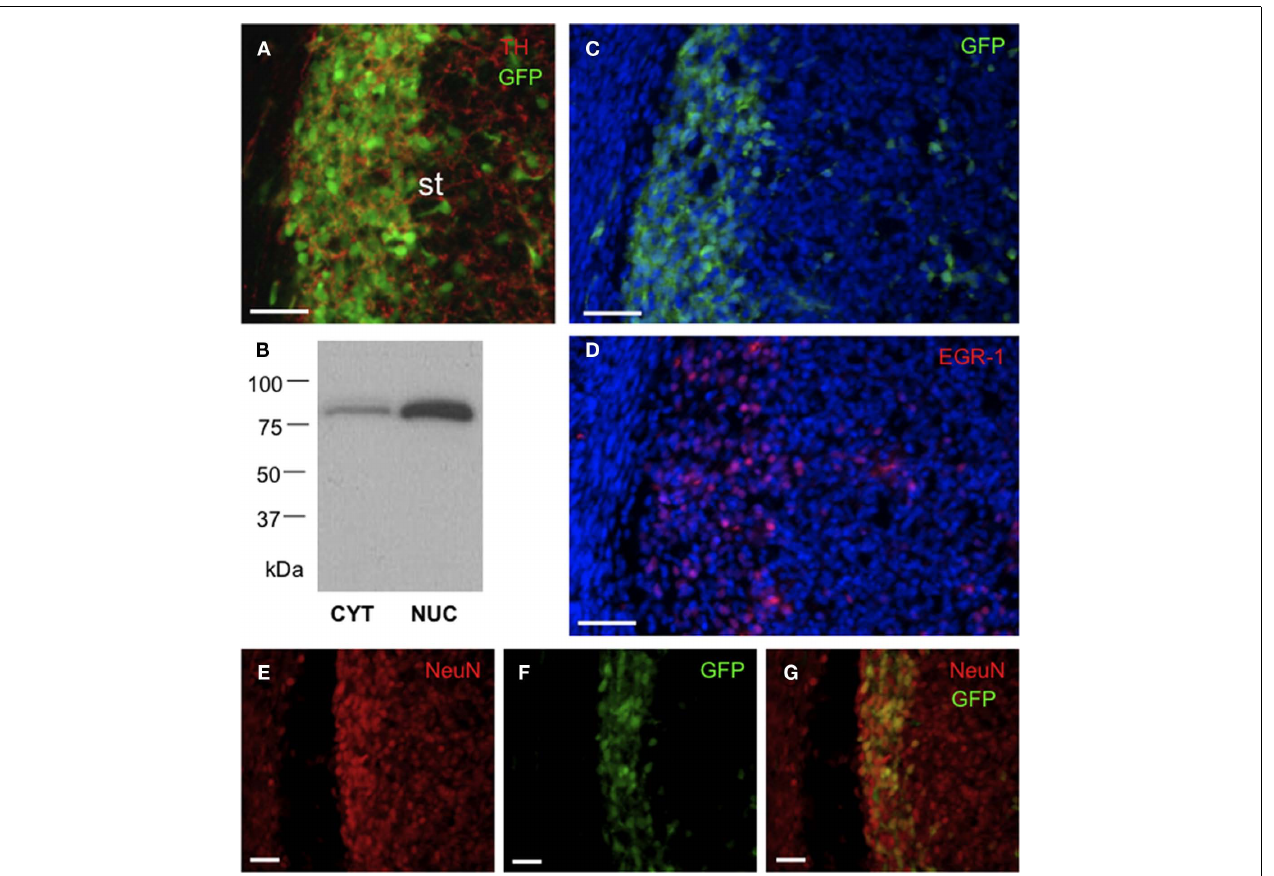
extracts (25 μ g) probed with an antibody to EGR-1. Note that the antibody primarily detects a single, approximately 80kDa, nuclear protein band. (C,D) Analysis of adjacent brain sections showing the similar distributions of GFP + and EGR-1 + cells; packed in the lateral striatum and scattered in the medial striatum. Scale bars = 50 μ m. Abbreviations: st, striatum;TH, tyrosine hydroxylase. (E–G) GFP is primarily localized in NeuN + neurons of the lateral striatum. Scale bar = 20 μ